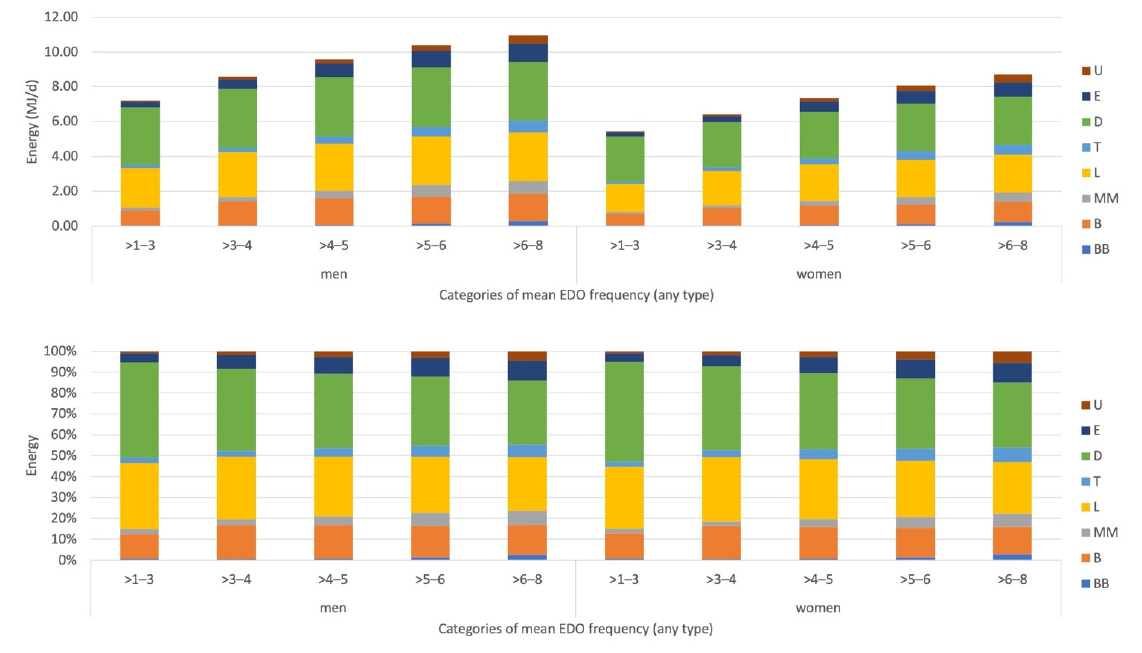
Figure 3. Mean reported energy intake for every recording section by EDO frequency, results are presented in absolute DEI (top, MJ/d) and relative to DEI (bottom, %DEI). Table 1. Association between DEI and/or EDO frequency and triglyceride concentrations a